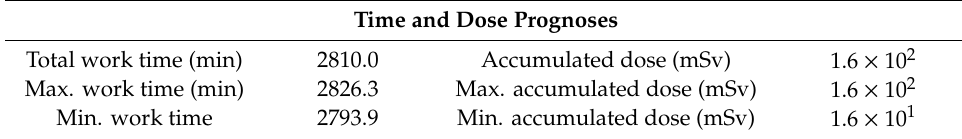
Table 9. Work time and estimated dose for the segmentation of the upper part.